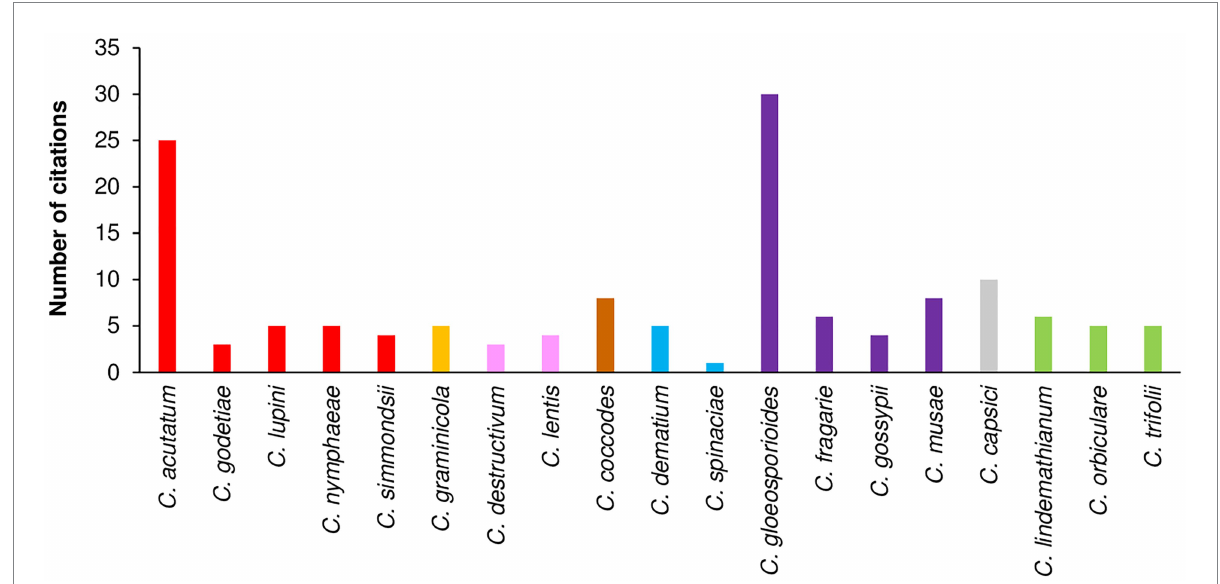
FIGURE 5 Number of citations that evaluated the influence of temperature on mycelial growth, conidial germination, conidial infection, or sporulation per species. Clades are indicated by different colors: red is acutatum, orange is graminicola, pink is destructivum, brown is coccodes, blue is dematium, purple is gloeosporioides, gray is truncatum, and green is orbiculare.